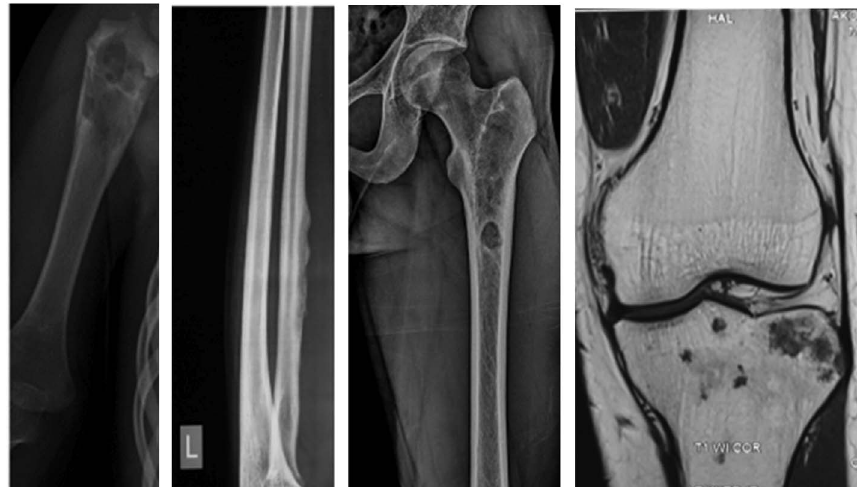
Figure 2. Patients referred based only on imaging diagnosed as unicameral bone cyst, periosteal osteogenic sarcoma, osteoid osteoma, and metastasis; the diagnosis was, however, con fi rmed on histopathology.